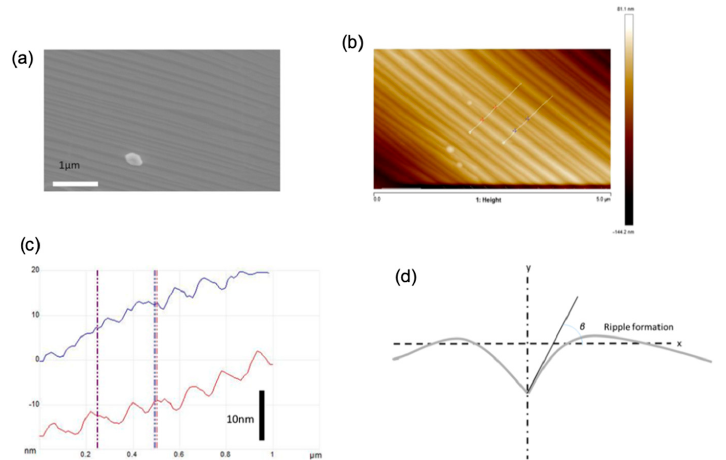
Figure 30. ( a ) SEM image showing the ripples in the graphene surface (4 ripples / 1 µ m); ( b ) AFM image of the formation of ripples in graphene; ( c ) height profile of the two sections shown in ( b ); ( d ) section showing a profile of an ideal thermal groove (reprinted with permission from [78]).